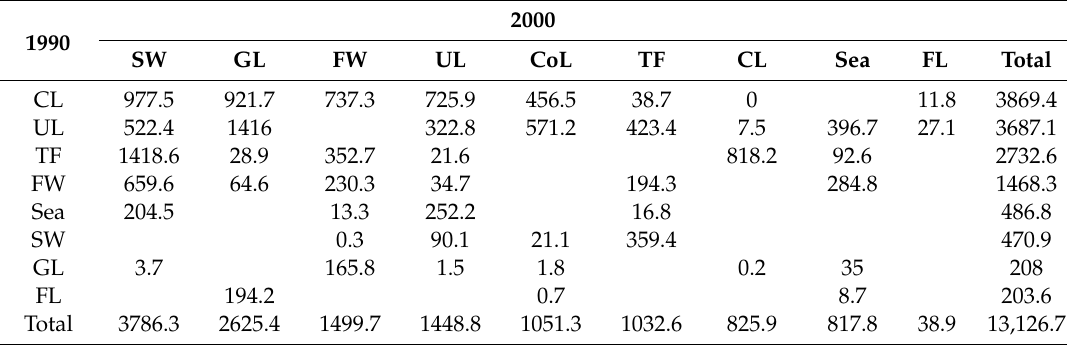
Table 4. Land use transformation matrix, 1990–2000 (in km).